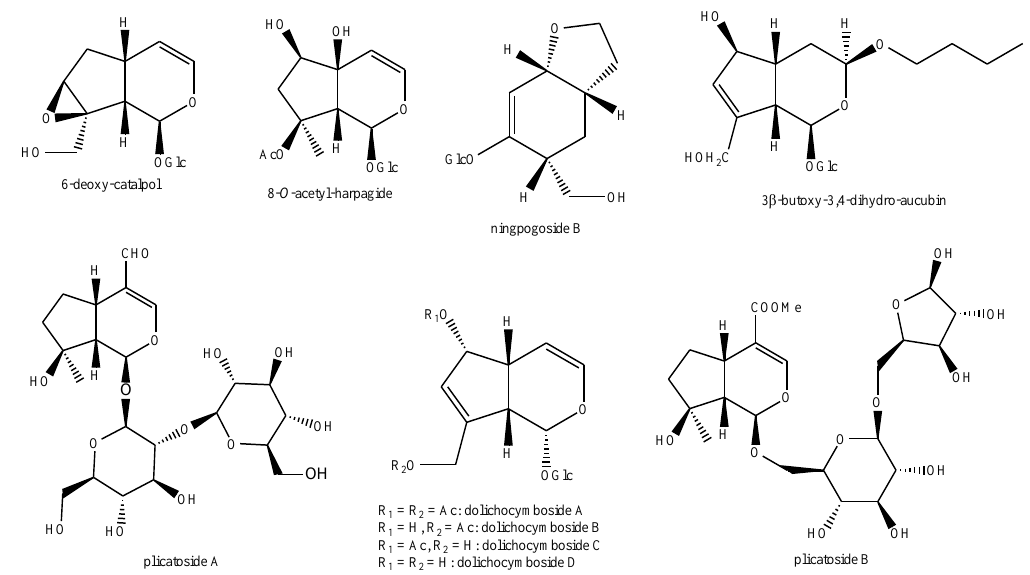
Figure 16. Iridoids identified in Pedicularis species—part 2.